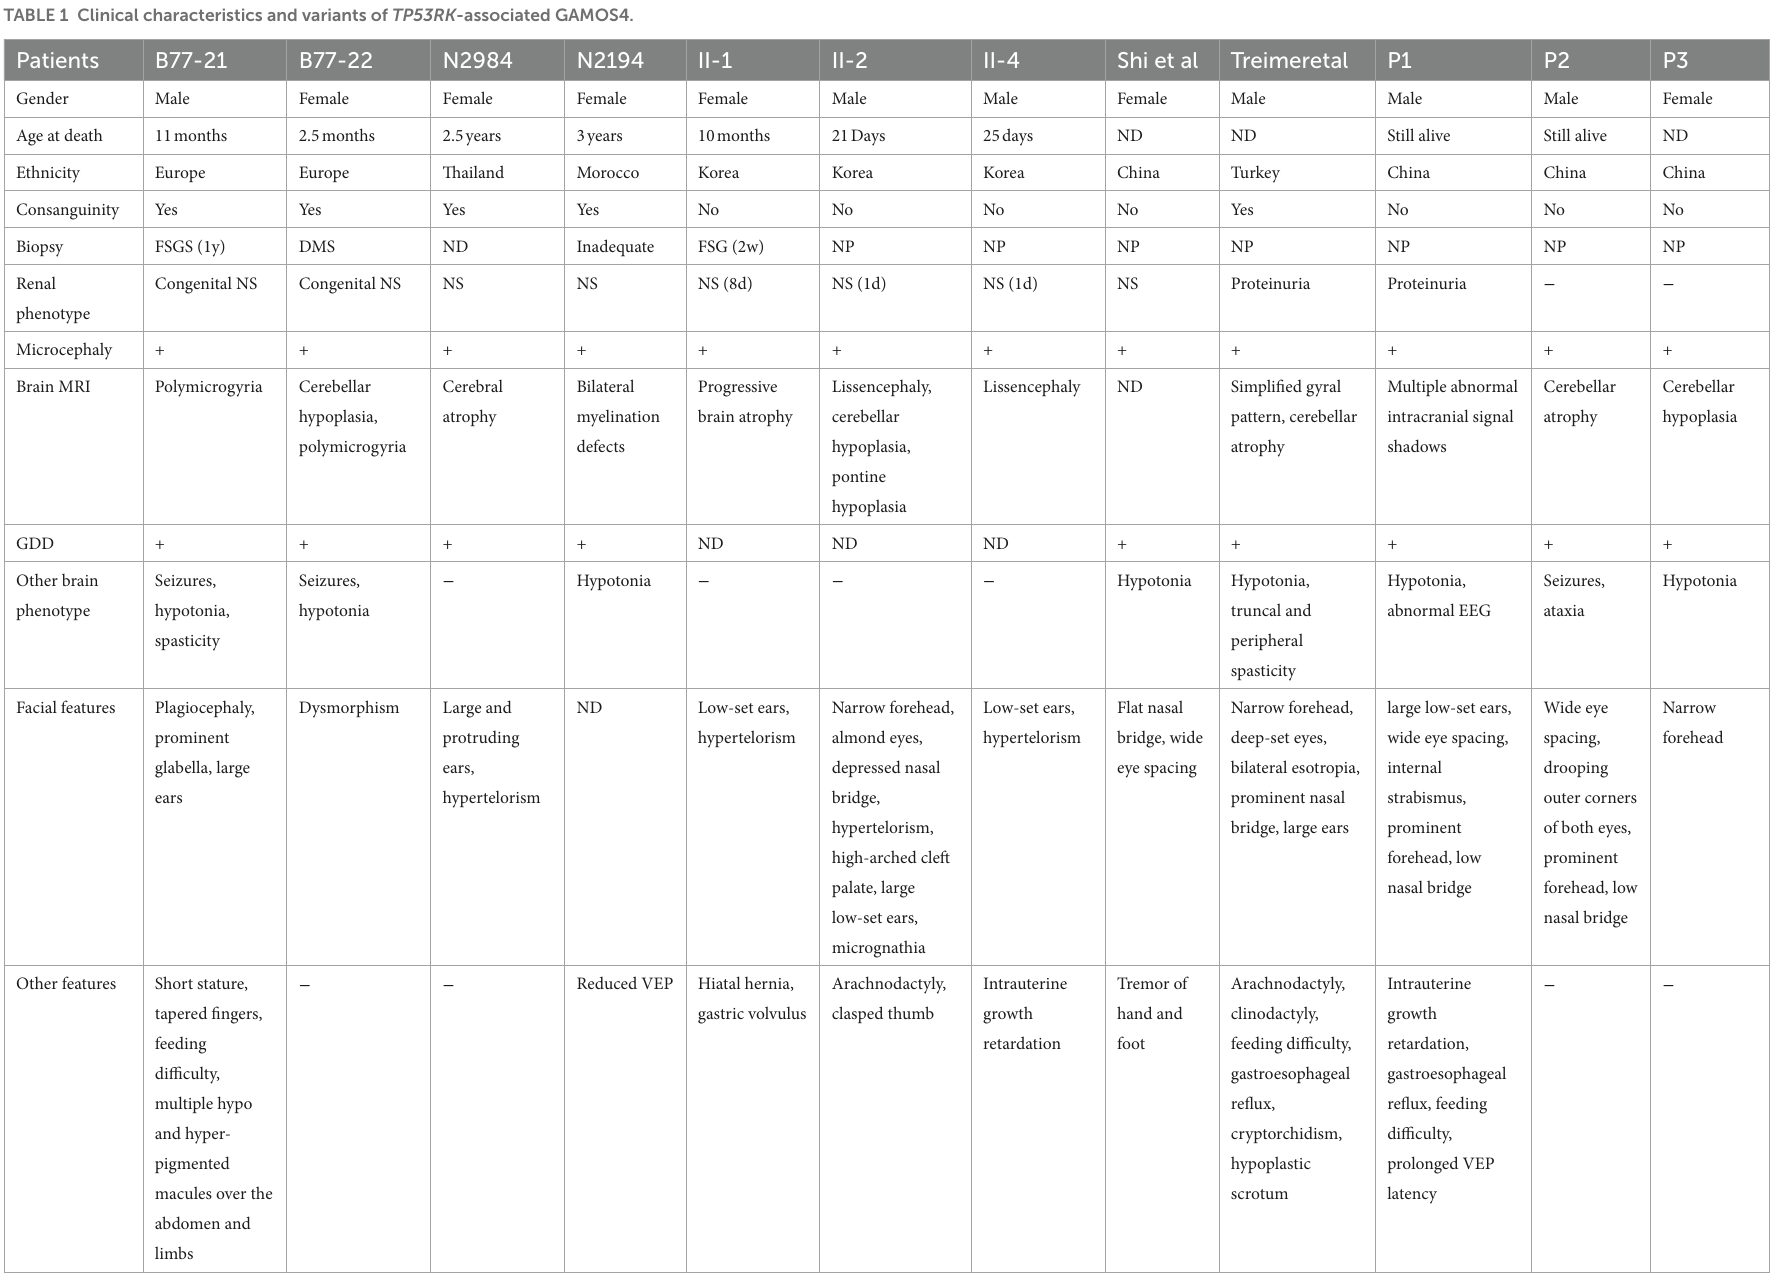
TABLE 1 Clinical characteristics and variants of TP53RK -associated